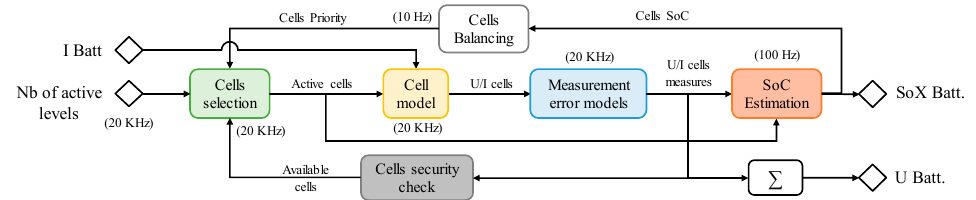
Figure 4. High Frequency Self-Reconfigurable Battery model synoptic.